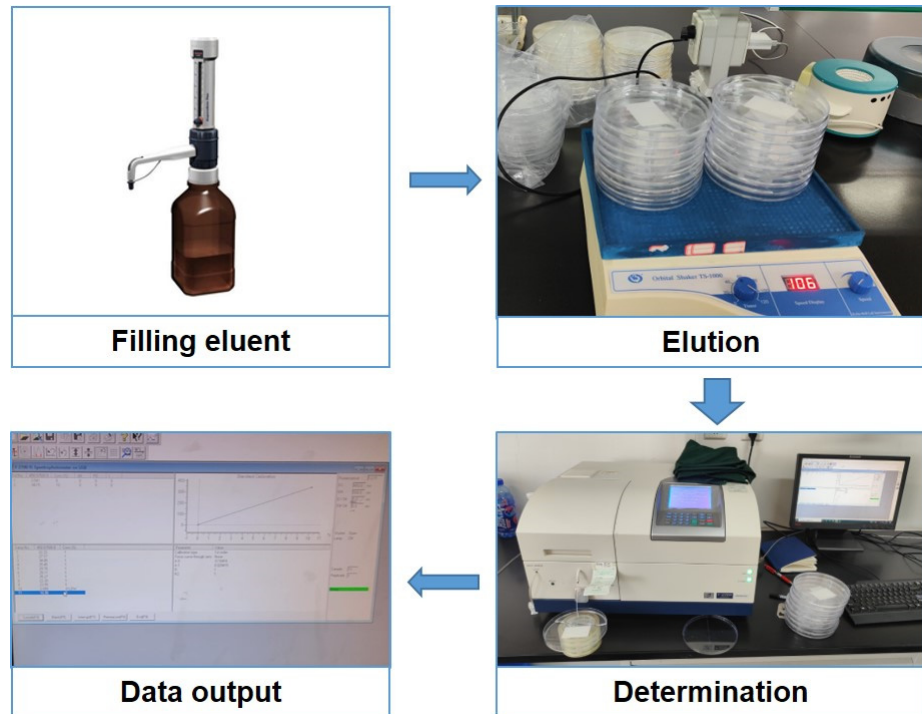
Figure 4. Sample processing procedures of UASS spray drift collectors.